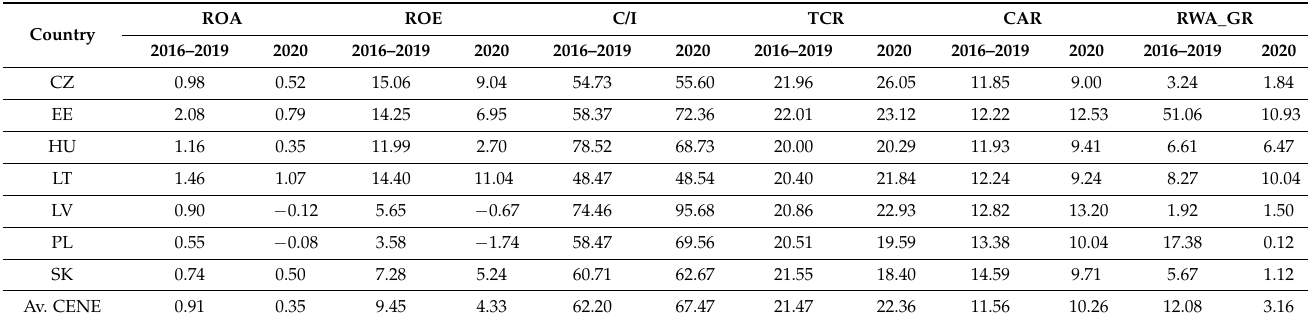
Table 2. The average performance ratios for CENE banking sectors: major indicators ROA, ROE, C/I, CAR, TCR, and risk-weight asset growth (RWA_GR). ROA Country